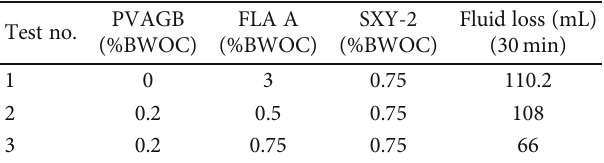
Table 6: Fluid loss test (PVAGB and FLA A compound additives). Test